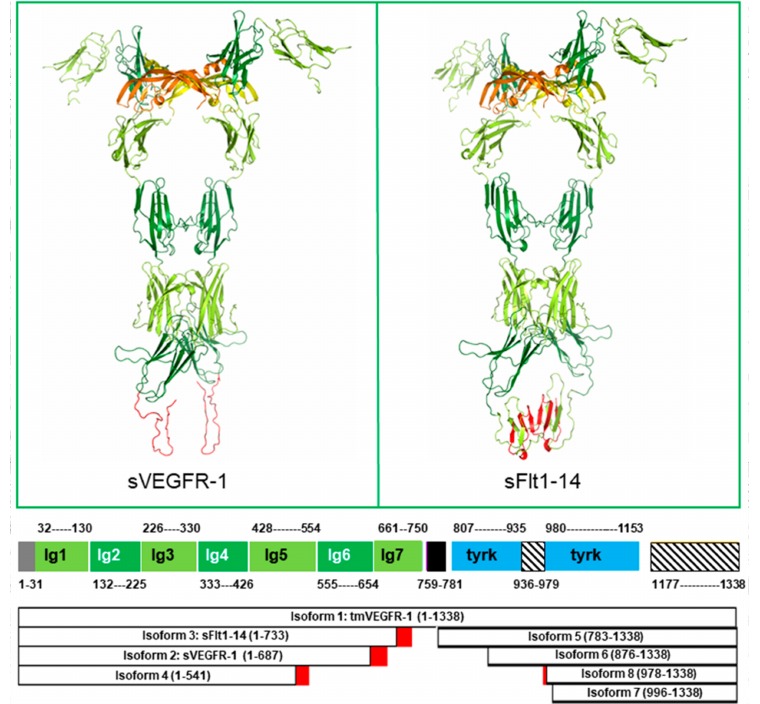
Figure 2. VEGFR-1 structures. Top: Soluble isoforms sVEGFR-1 ( left ) and sFlt1-14 ( right ) are